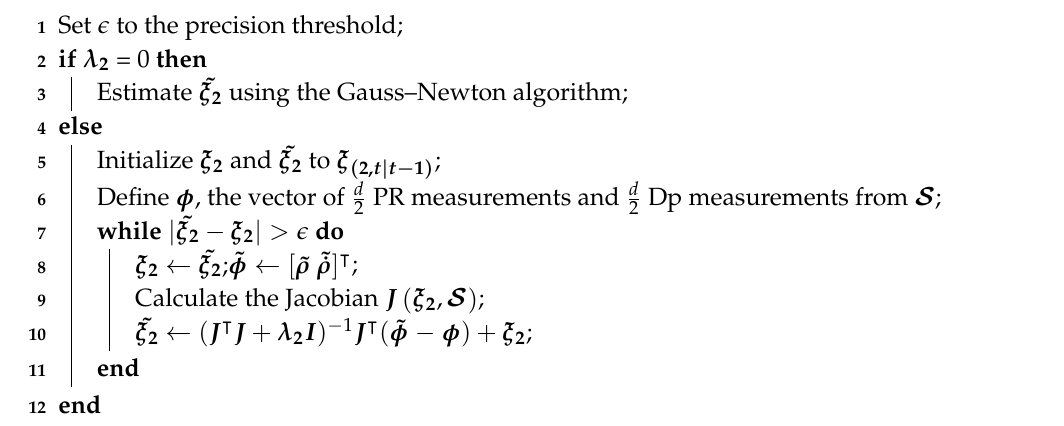
(cid:0) (cid:1) x S , y S , z S , ˙ x S , ˙ y S , ˙ z S , ˙ ρ i , i i i i i i